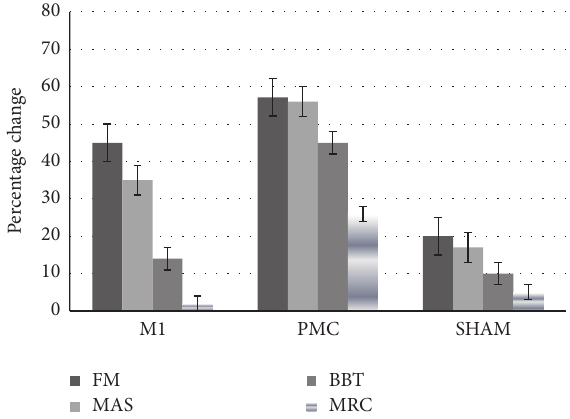
Figure 4: Percentage change in secondary outcomes from base- line to endpoint in the experimental groups. FM: Fugl-Meyer Assessment-UpperExtremityscale.MAS:ModifiedAshworthScale. BBT: Box and Block Test. MRC: Medical Research Council